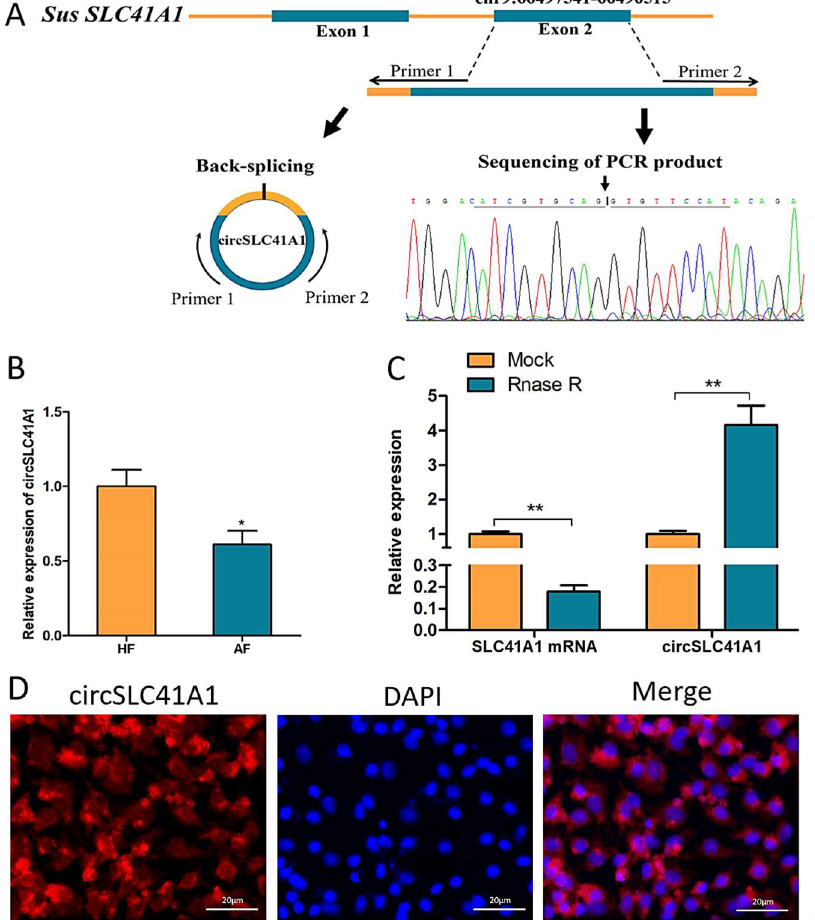
Figure 1. Identification and validation of circSLC41A1. ( A ) Sketch of the structure of circSLC41A1, which is generated from the SLC41A1 gene exon 2 via back splicing. ( B ) SLC41A1 mRNA and circSLC41A1 expression with and without RNase R digestion. Untreated GAPDH was used as an internal control. ( C ) Differential expression of circSLC41A1 in HFs and AFs detected by qRT-PCR ( n = 8). ( D ) The cytoplasmic localization of SLC41A1 in GCs detected by FISH. SLC41A1 was labeled with red fluorescence, and the nuclei were stained by DAPI (blue). Scale bar: 20 μm. Data are expressed as the mean ± SEM, * p < 0.05, ** p < 0.01.